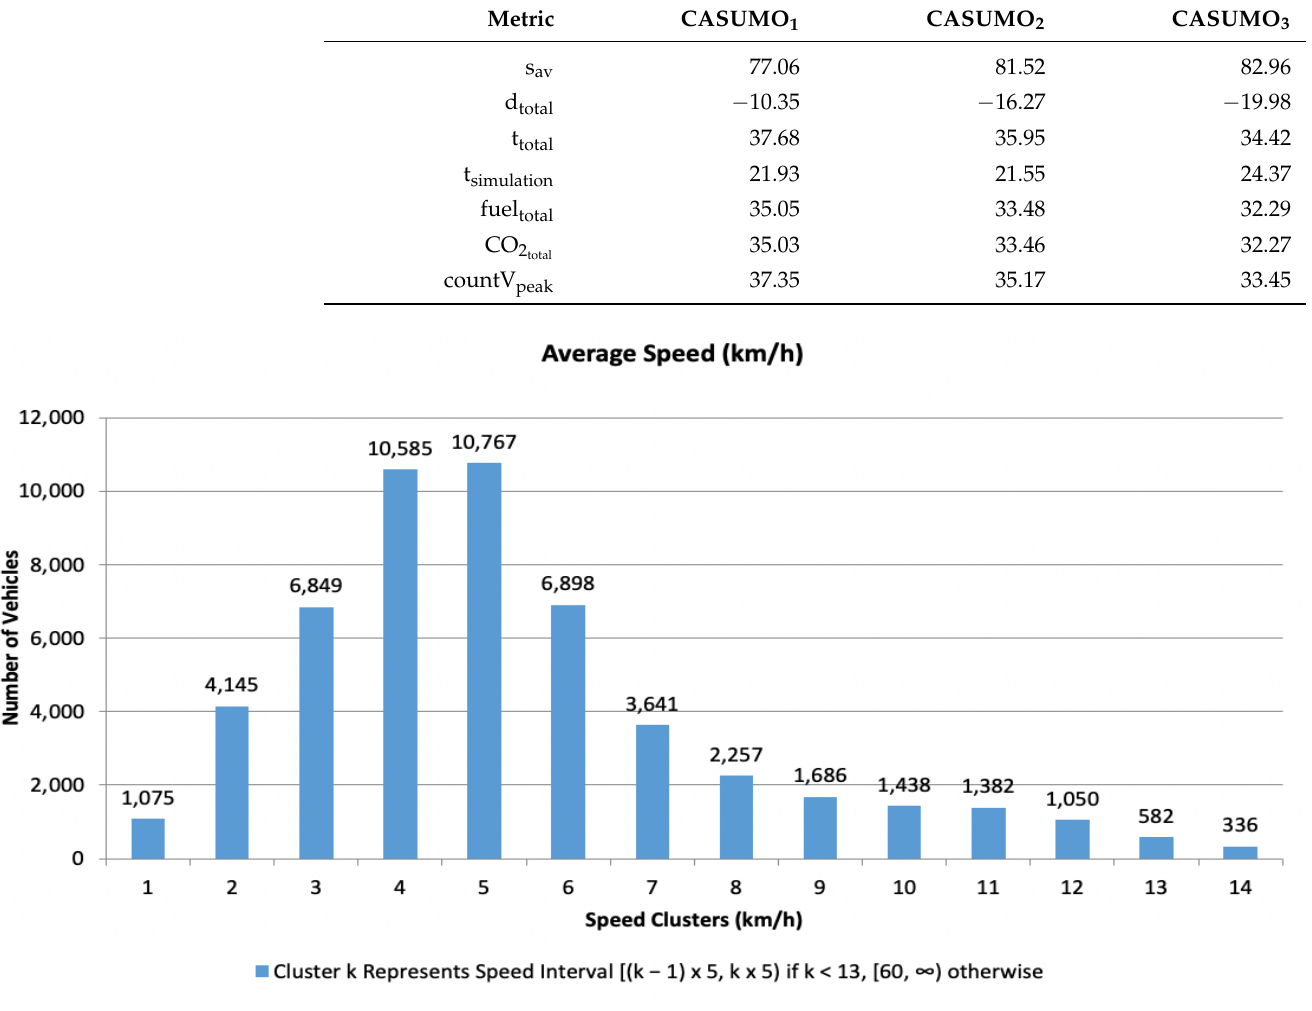
Figure 5. Speed distribution in clusters for 50 K+ simulated vehicles in Barcelona with δ = 1.